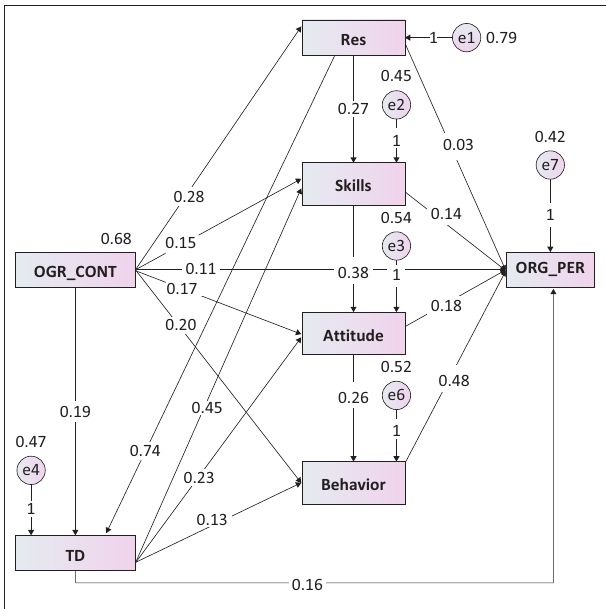
FIGURE 3: Individual results.